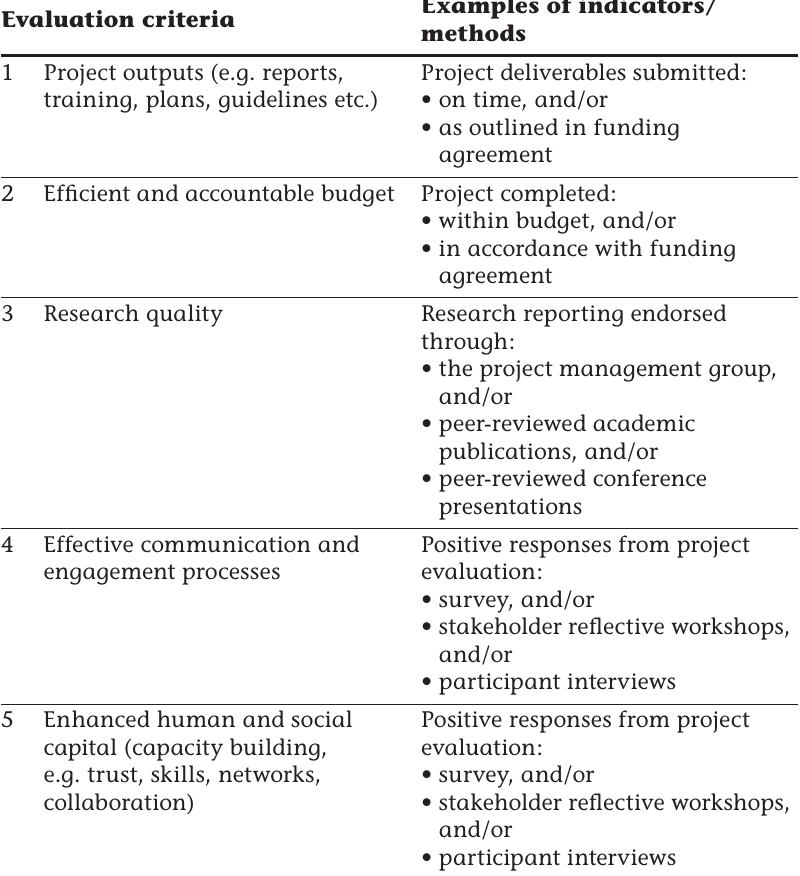
Table 2: Project evaluation